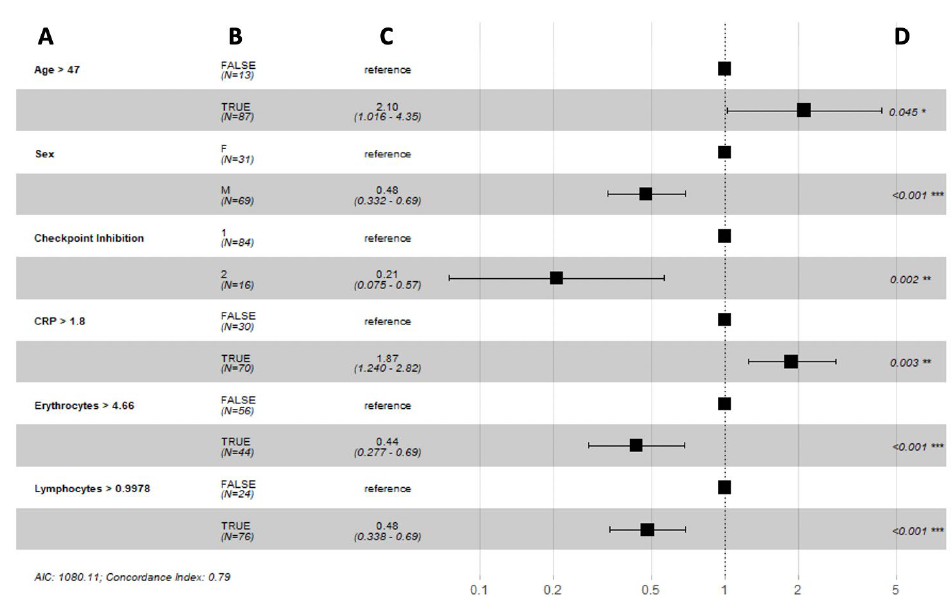
Figure 6. Forest plots summarizing the results of a Cox proportional hazard model analysis of overall survival with optimal cut-off values of time-varying covariates: ( A ) variable; ( B ) number of patients; ( C ) hazard ratio (95% CI); ( D ) p -value. Abbreviations: F = female, M = male, 1 = single ICI, 2 = double ICI, CRP = c-reactive protein, AIC = Akaike information criterion. *, ** and *** indicate significance at the 0.1, 0.05 and <0.01 levels respectively.